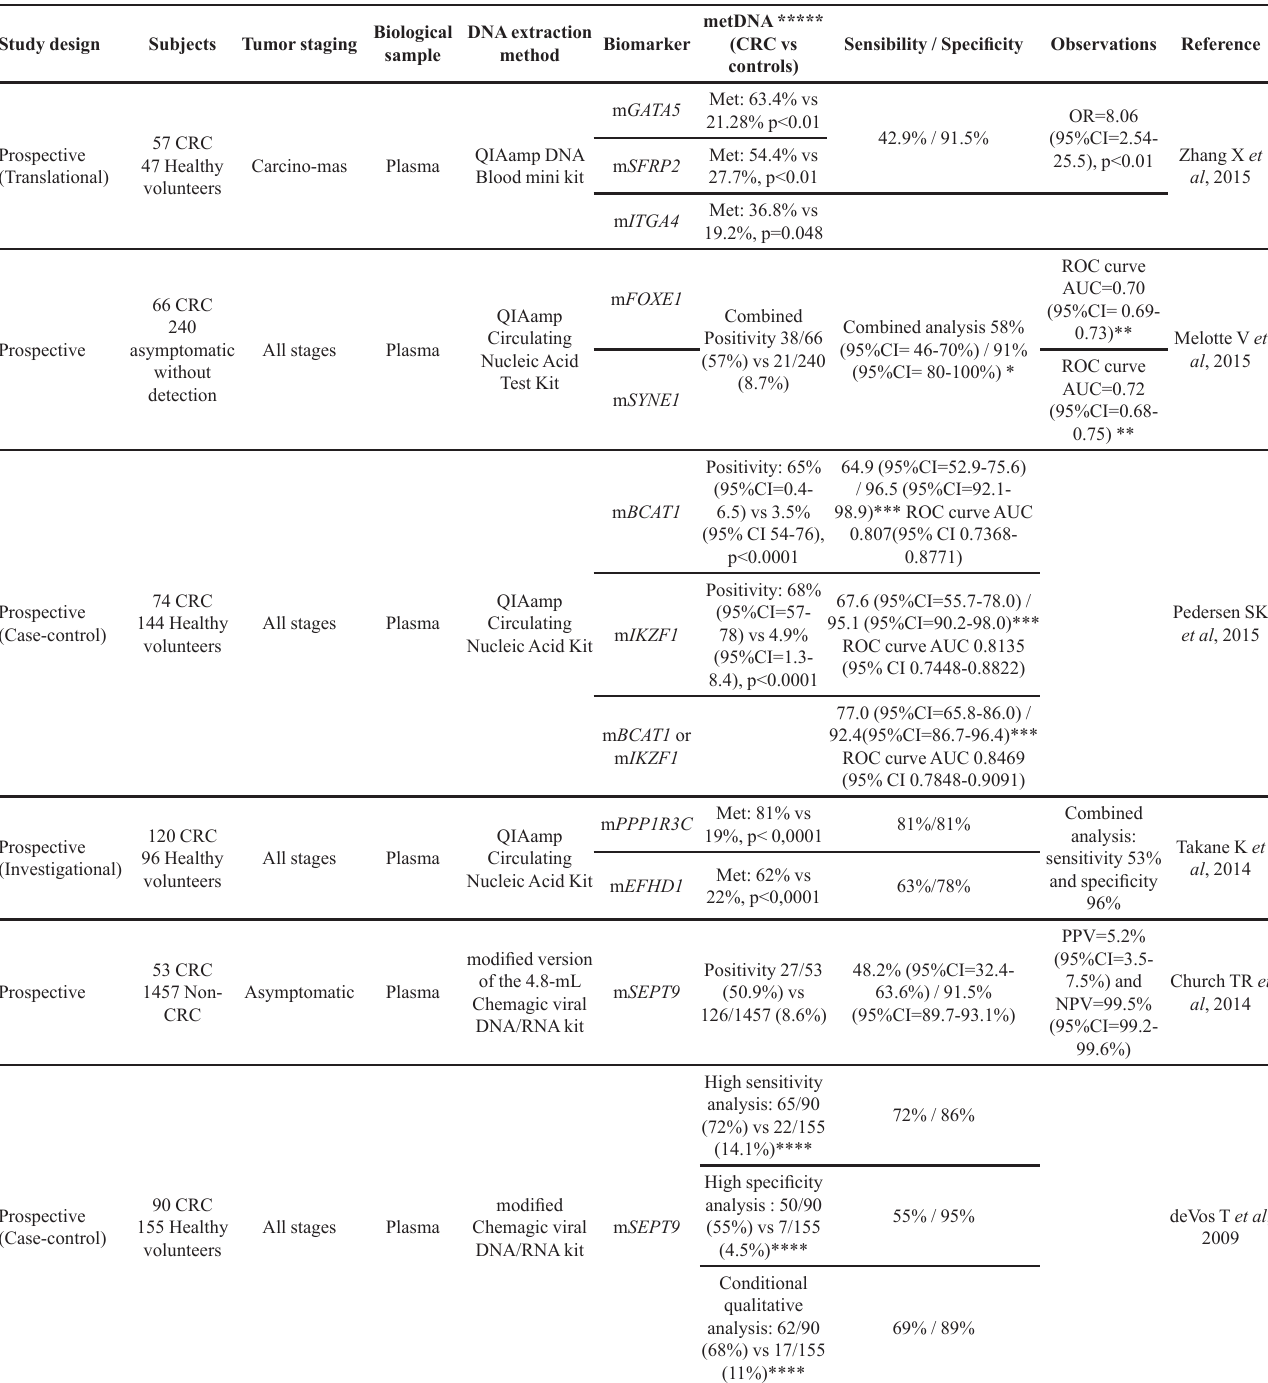
TABLE IV - Clinical studies that evaluated the methylated biomarkers in the ccfDNA for the CRC diagnosis